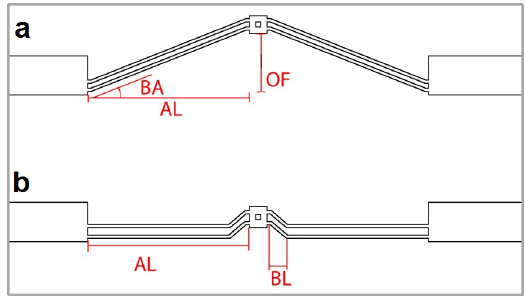
Figure 2. A schematic detailing the design parameters and the differences between ( a ) the Chevron and ( b ) the Kink